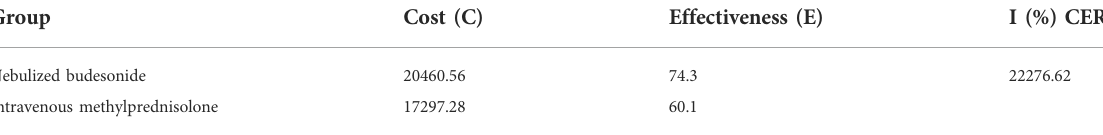
TABLE 5 Base case results of the cost-effectiveness analysis.